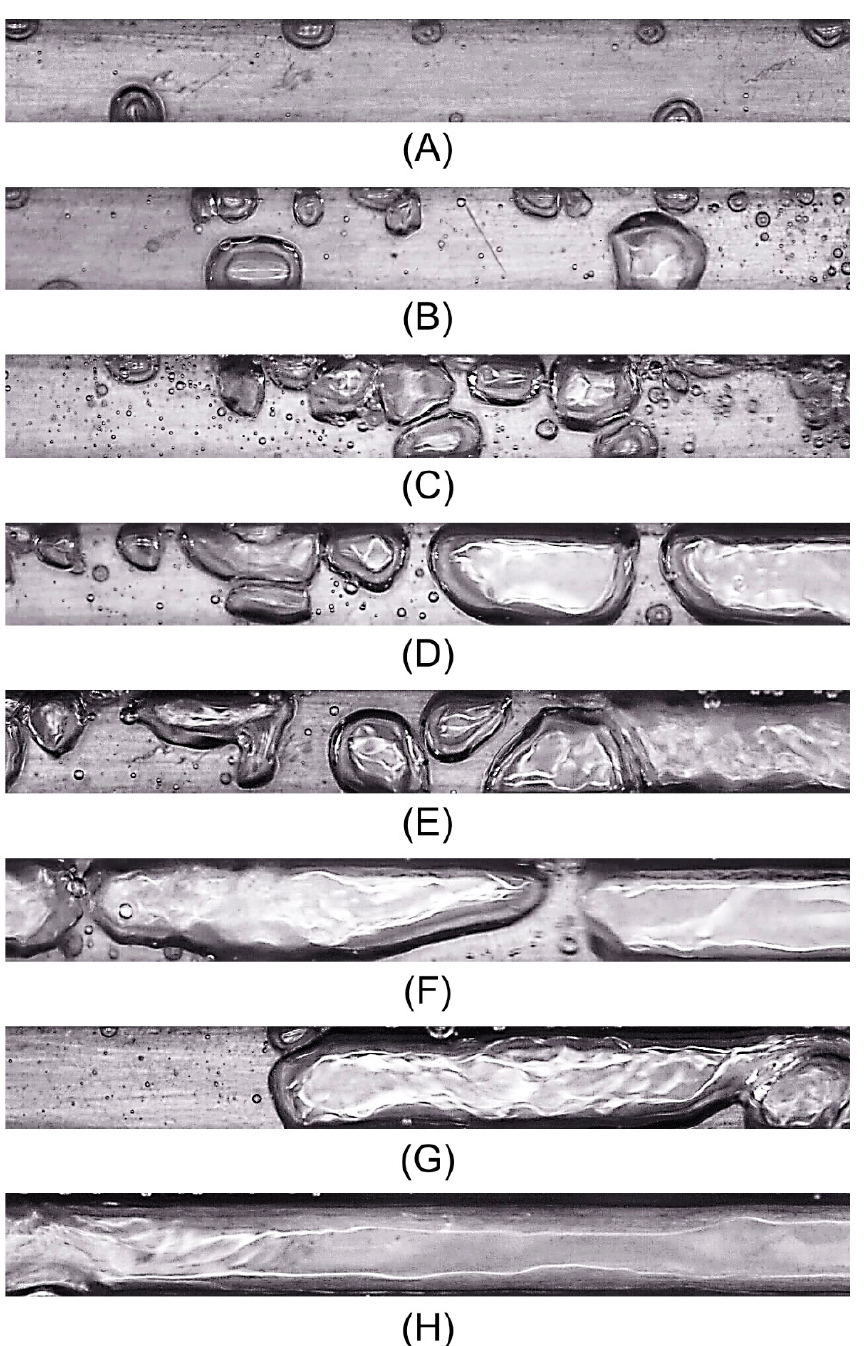
Figure 10. Examples of boiling two-phase flow structures observed in the horizontal mini-channel: ( A ) visible small amount of vapor bubbles—boiling initiation; ( B ) bubble flow in entire channel; ( C ) vapor bubbles concentrate in clusters leading do vapor corks; ( D ) cork flow with the presence of small bubble structures; ( E ) intense cork flow, presence of pressure pulsations; ( F ) growing corks and beginning of film flow; ( G ) film flow in the form of large corks; ( H ) film flow, filling the channel totally with vapor.